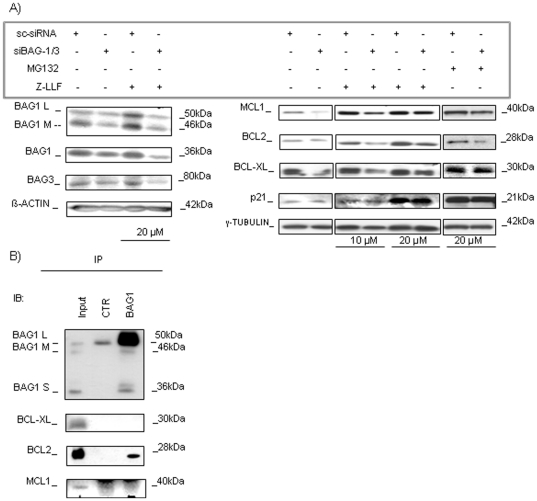
Proteasome inhibition study and co-immunoprecipitation analysis.A) WB analyses after BCS and reversible block of proteasome for 4 h with chemical agents, MG132 (20 µM) and Z-LLF (10 µM and 20 µM), are presented. The eventual changes in BCL2, BCL-XL, and MCL1 protein expression were checked. p21 served as a standard control for proteasome blocking [51], and β-ACTIN and γ-TUBULIN are shown as total protein loading controls. B) Analysis of possible co-interaction between BAG1/BCL-XL, BAG1/BCL2 and BAG1/MCL1 proteins done by immunoprecipitation (IP) and WB is shown.